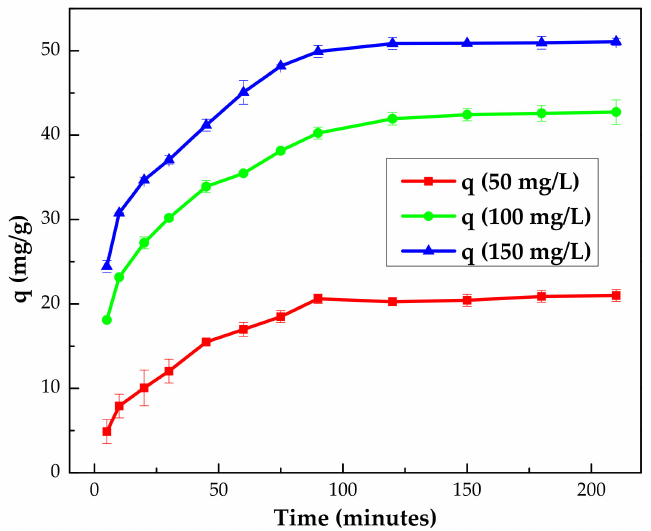
Figure 10. Effect of time on phenol adsorption onto the IL–agar–alginate beads ( Ci = 150 mg/L, pH of 2, 150 rpm, 2 h, beads dosage = 1 mg/mL and at 25 ◦